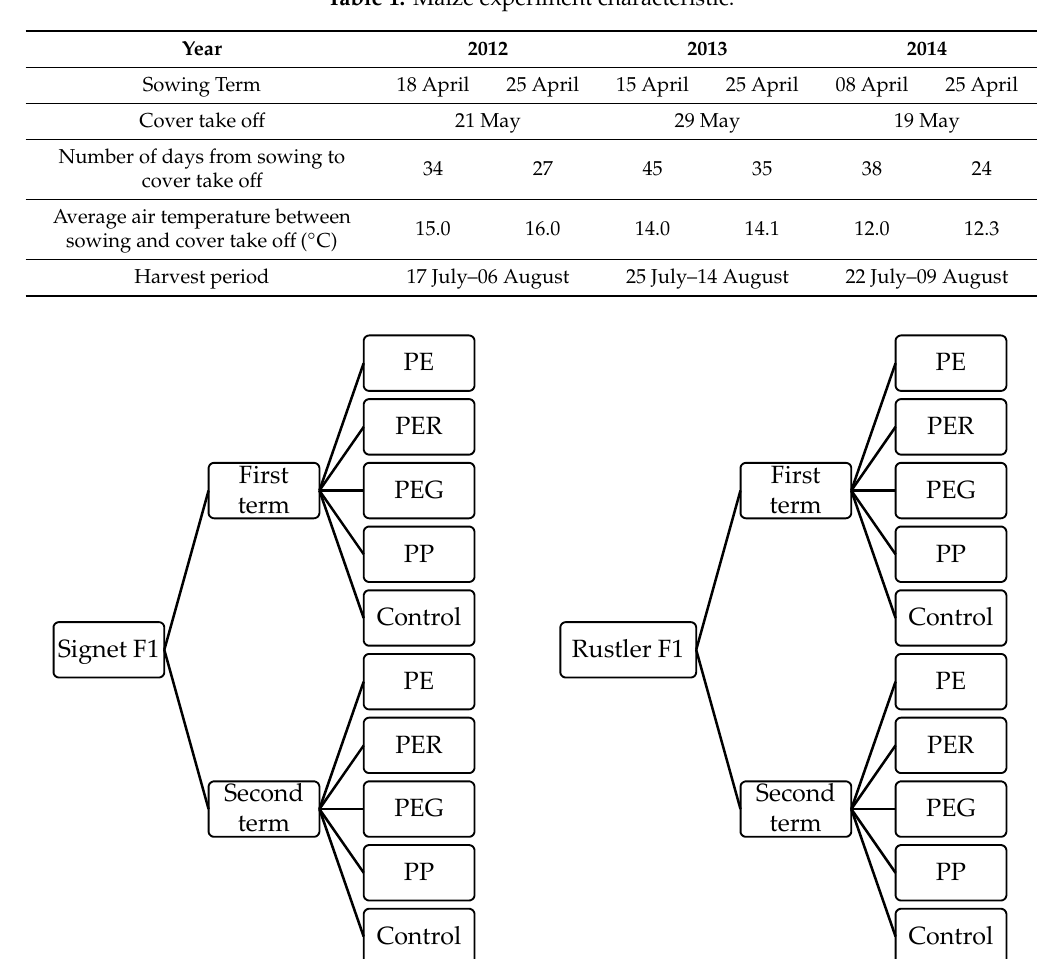
Table 1. Maize experiment characteristic.